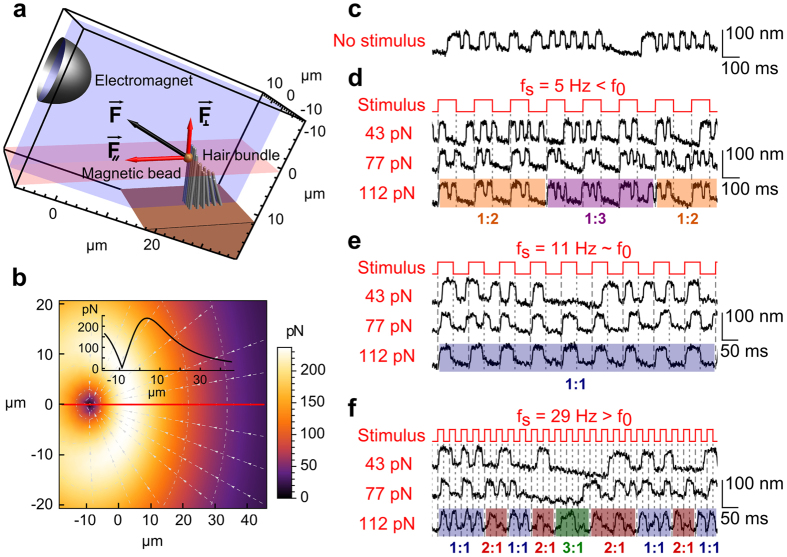
Experimental setup and entrainment of hair bundle dynamics.(a) Scaled schematic of a hair bundle that protrudes from the apical surface of the saccular epithelium; the bundle is coupled to a magnetic bead and stimulated by the electromagnetic probe. The symmetry plane and the plane of bundle motility are indicated in blue and red respectively. (b) Projection of the magnetic force acting on an average bead onto the plane of bundle motility (red plane). The origin of the plane corresponds to the projection of the tip onto the plane. The inset presents the force intensity along the red line. (c) Spontaneous oscillations of a hair bundle. Hair bundle oscillations in the presence of a square-wave stimulus, applied at increasing intensities for (d) fs < f0, (e) fs ~ f0, and (f) fs > f0. The modes of synchronization are indicated for the highest stimulation intensity.